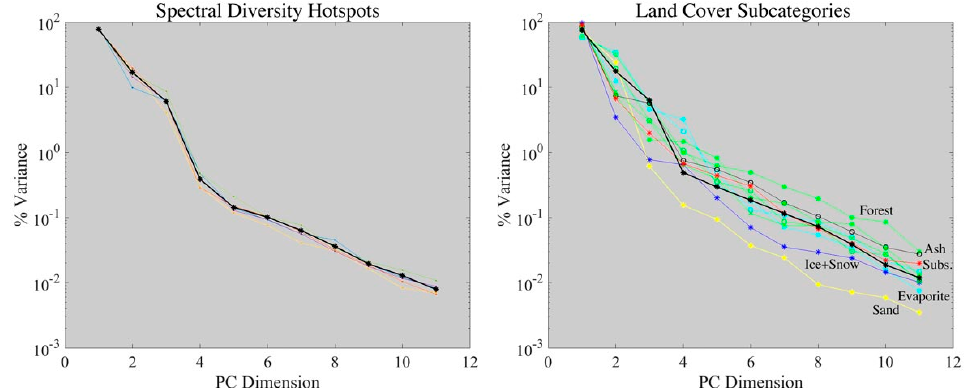
Figure 3. Spectral dimensionality from variance partition. Five 20 tile subsets (left) each have very similar variance partition to the full 110 tile aggregate (black) with 99% variance in the first 3 dimensions. The aggregate of 120 land cover subcategory subsets (right-black) also has very similar variance partition with 98% in the first 3 dimensions. The individual land cover subcategories vary somewhat, with sand and ice + snow having lower dimensionality than more heterogeneous categories. All have < 1% variance in all dimensions >4. Both mosaics can be considered 3D in the sense that the 3 low order dimensions represent >98% of total variance.